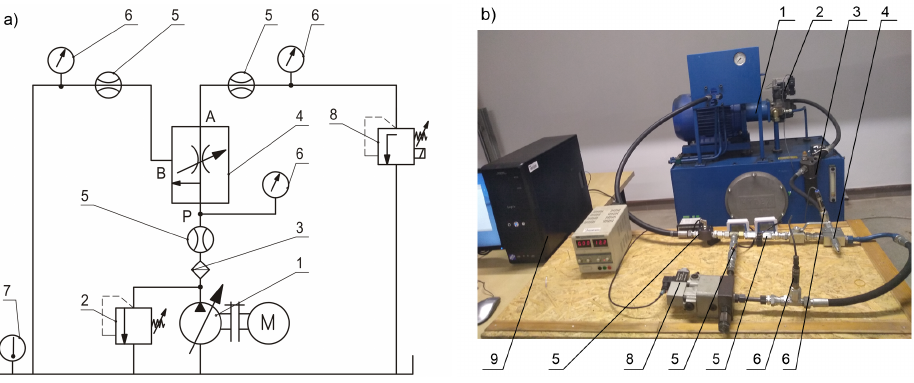
Figure 17. Test bench: ( a ) scheme, ( b ) view; 1—pump; 2—safety relief valve; 3—filter; 4—flow control valve; 5—flow meter; 6—pressure transducer; 7—thermometer; 8—relief valve; 9—Data acquisition unit. Table 5. Measuring and data acquisition equipment parameters.